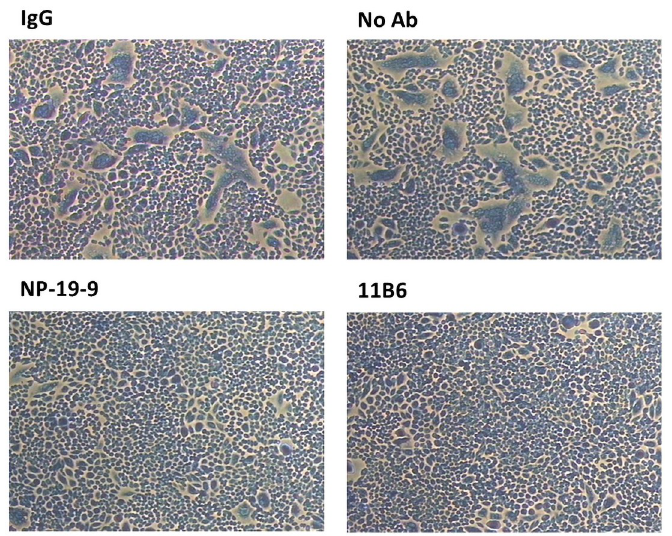
Fig 5. Inhibitory effect of anti-rabies virus mAbs on ERA G-protein-induced membrane fusion assay. Cells were treated with TPCK-trypsin and were subject to low pH condition. Syncytia formation is apparent for the control group (up, IgG and Control) whereas when treated with NP-19-9 or 11B6, syncytia formation is drastically decreased.